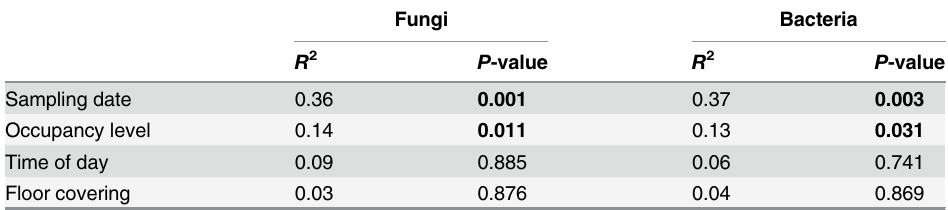
Table 2. Factors influencing microbial